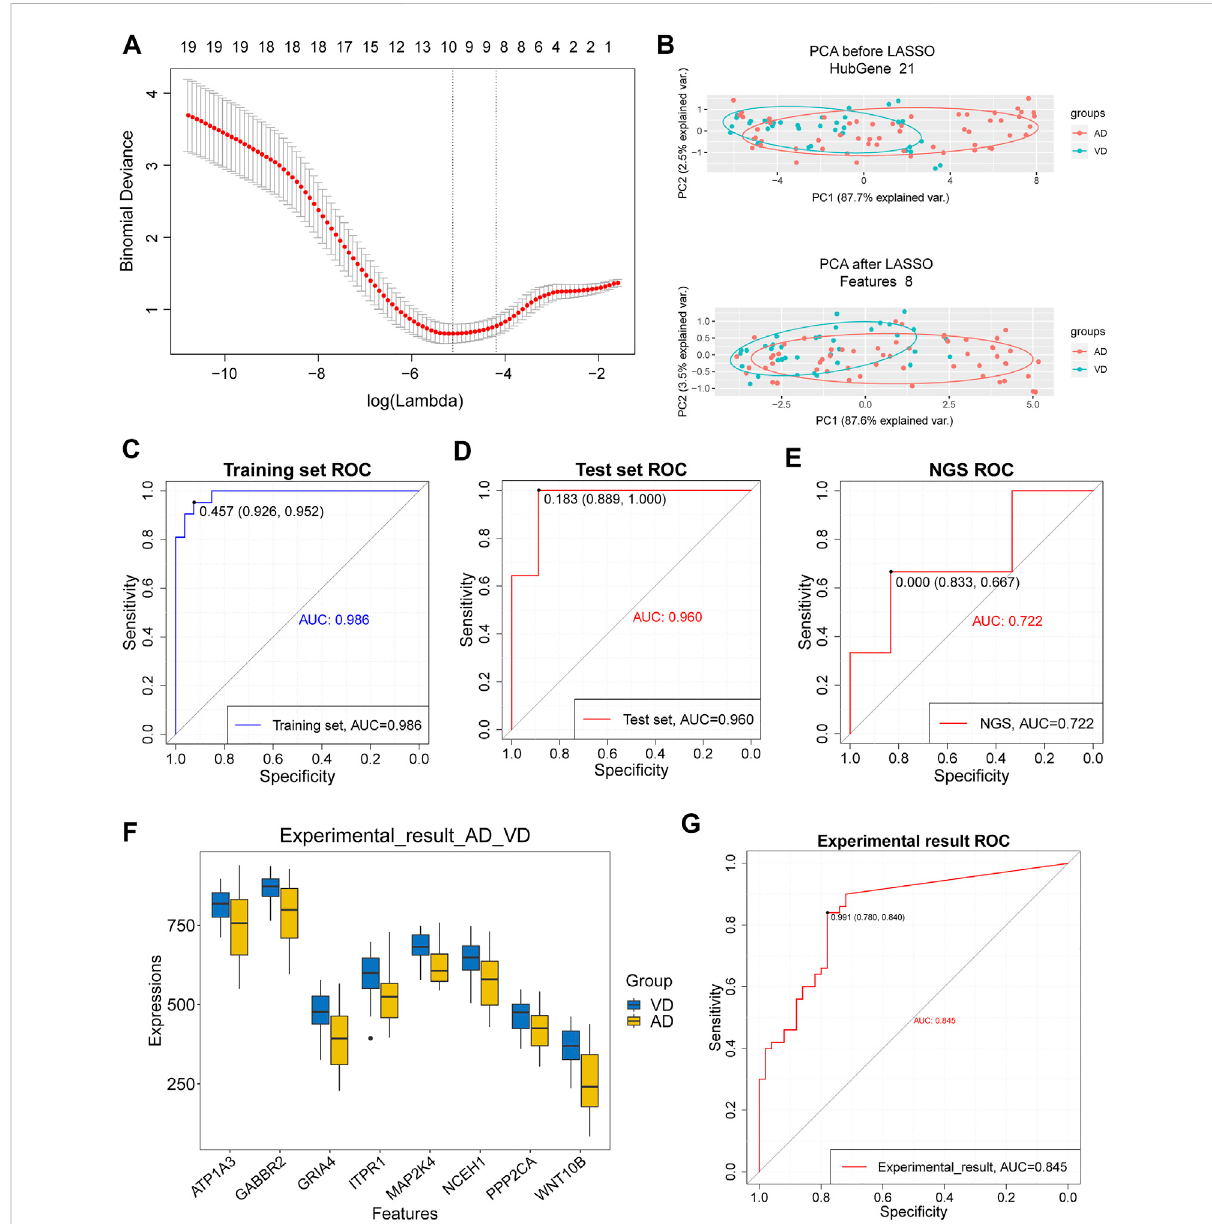
FIGURE 5 Assessment of models for identi fi cation of Alzheimer ’ s disease (AD) and vascular dementia (VD). (A) 10-fold cross-validation for tuning parameterselectionintheLASSOmodel. (B) PCApriortoandafterLASSOvariablereduction.LASSO,leastabsoluteshrinkageandselectionoperator; PCA,principalcomponentanalysis. (C,D) ROC curveforpatients withAD andpatientswith VDinthetraining andtestsets. (E) ROC curveforpatients with AD and patients with VD in the NGS dataset. (F) Gene expression levels in patients with AD and patients with VD in the NGS and GSE122063 data sets. The thick black bar in the middle indicates the interquartile range, and the black line extending from it represents the 95% con fi dence interval. (G) ROC curves for patients with AD and patients with VD in the NGS and GSE122063 data